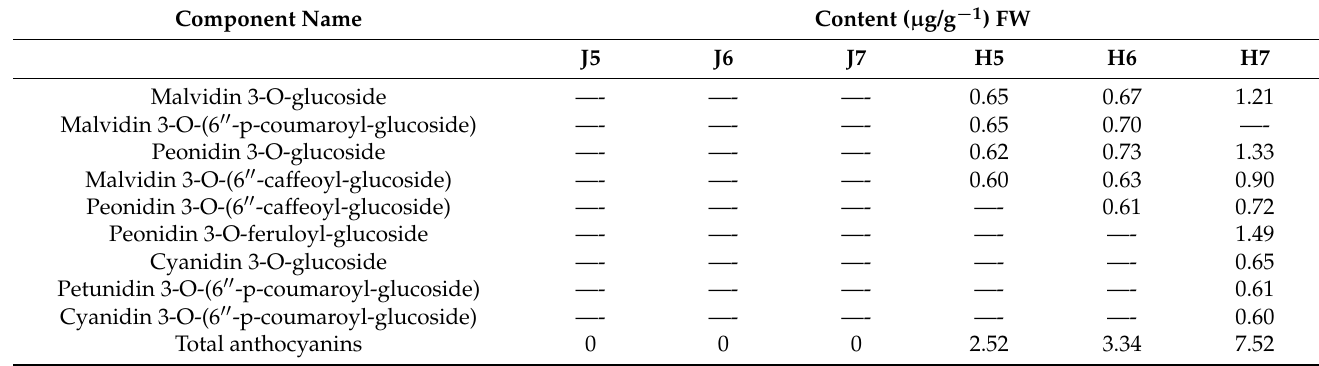
Figure 6. Prediction of cis -acting elements in the GST promoters. The 2000 bp sequence upstream of the promoters was analyzed and different regulatory elements are shown in different colors. Table 1. Composition of anthocyanins in the flesh of ‘ZS-HY’. Note: ‘—-’ indicates that the substance was not